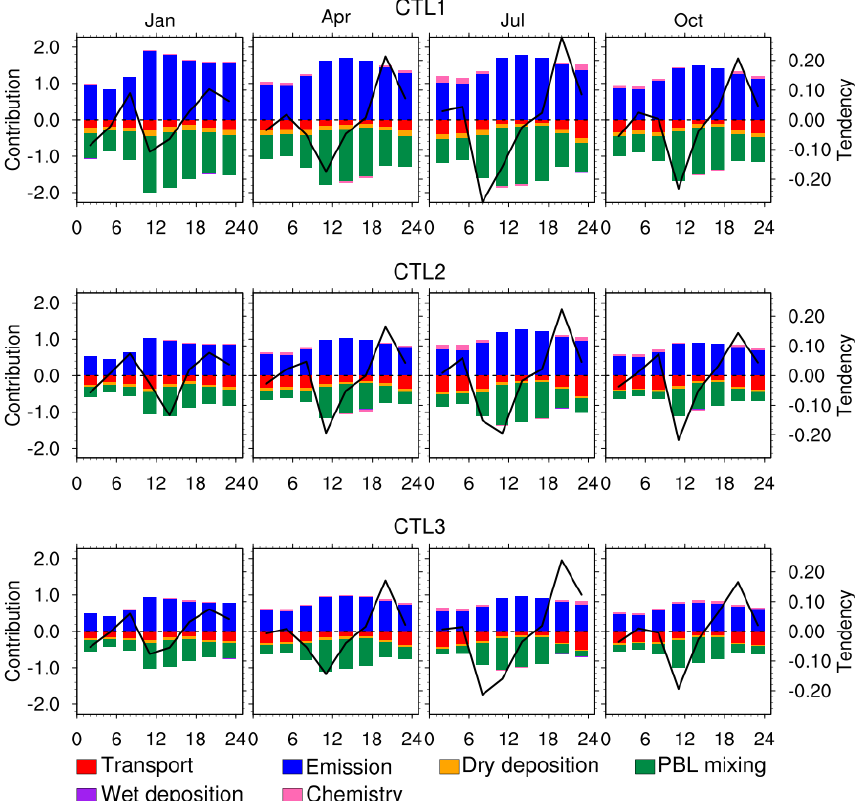
Figure 4. Relative contribution (normalized by monthly mean surface PM 2 . 5 concentrations for each month) to surface PM 2 . 5 concentrations every 3h from individual process (transport, emission, dry and wet deposition, PBL mixing, chemical production/loss) averaged over Hefei for January, April, July, and October of 2018 from experiments CTL1, CTL2, and CTL3. The 3-hourly relative tendency of surface PM 2 . 5 concentrations is also shown as the black